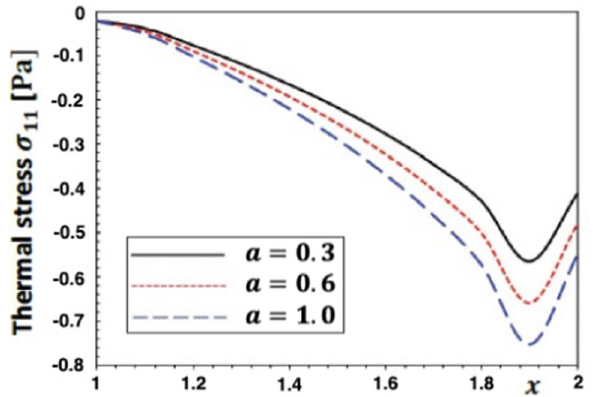
Figure 3. Variation of the thermal stress σ 11 along x -axis for different values of fractional order parameter.